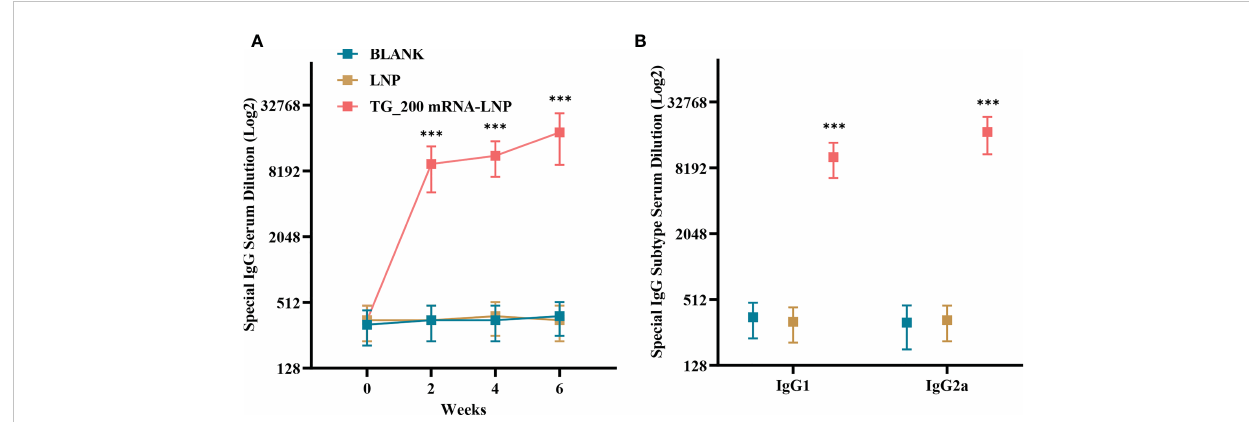
FIGURE 4 Detection of T. gondii speci fi c humoral immune responses induced by TG_200 mRNA-LNP immunization. (A) Serum from vaccinated mice was isolated at 0, 2, 4, and 6 weeks after vaccination and analyzed for IgG neutralization of serially diluted serum samples, n = 8/group. *** P < 0.001. (B) Serum from vaccinated mice was isolated 2 weeks after the boost and analyzed for IgG1 and IgG2a neutralization of serially diluted serum samples, n = 8/group. *** P < 0.001. Data are presented as the means ± SD.